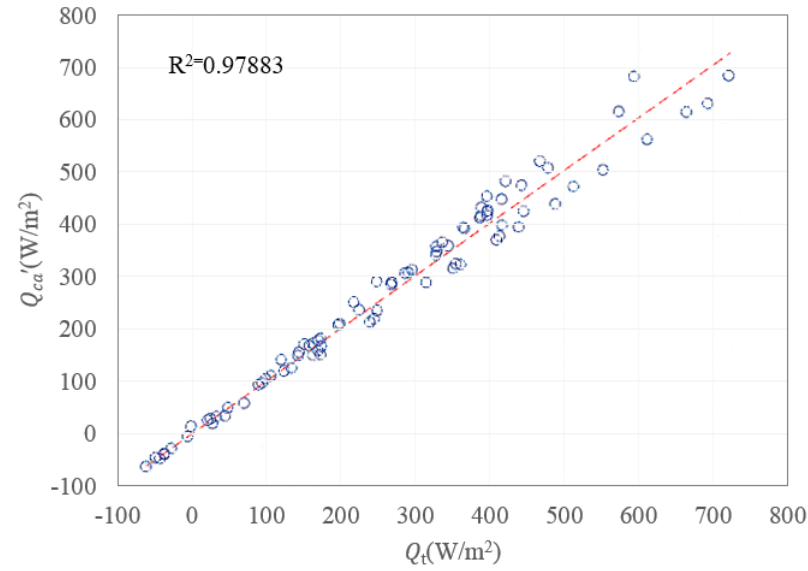
Figure 6. R 2 of the calibration